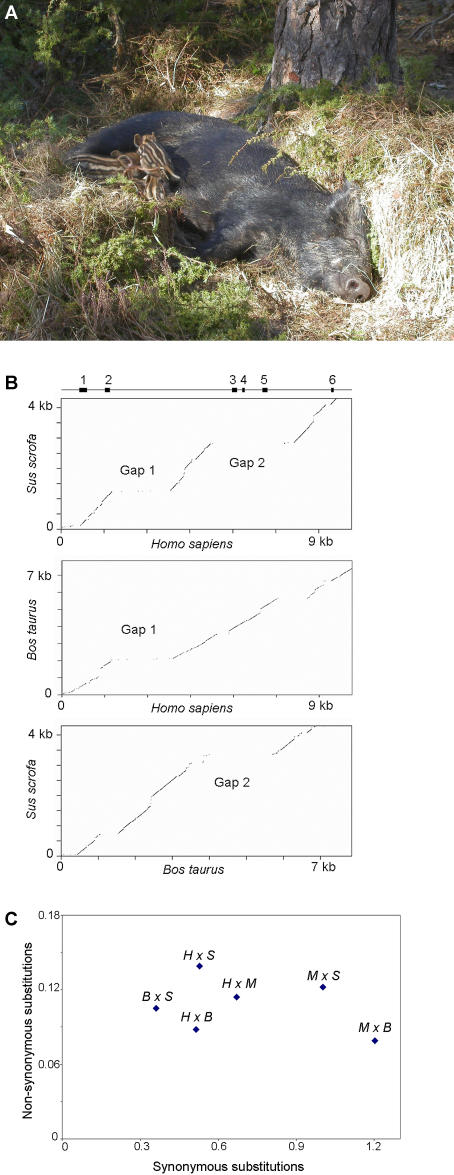
Characterization of the UCP1 Locus in Pigs(A) Wild boar sow with striped piglets in their nest.(B) Dotpath alignments of genomic UCP1 sequences from pigs, humans, and cattle. The approximate positions of the six exons in human UCP1 are indicated. Gap1 and Gap2 indicate two gaps in the alignment between the pig and human sequences.(C) Rate of nonsynonymous and synonymous substitutions in pairwise comparisons of UCP1 sequences from humans, mice, cattle, and pigs. The data are based on sequences from exon 1, 2, and 6. B, Bos taurus; H, Homo sapiens; M, Mus musculus; and S, Sus scrofa.(Photo: Anneli Andersson, Linköping University, Sweden)